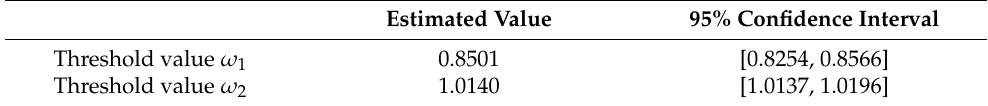
Table 6. Threshold estimation results.